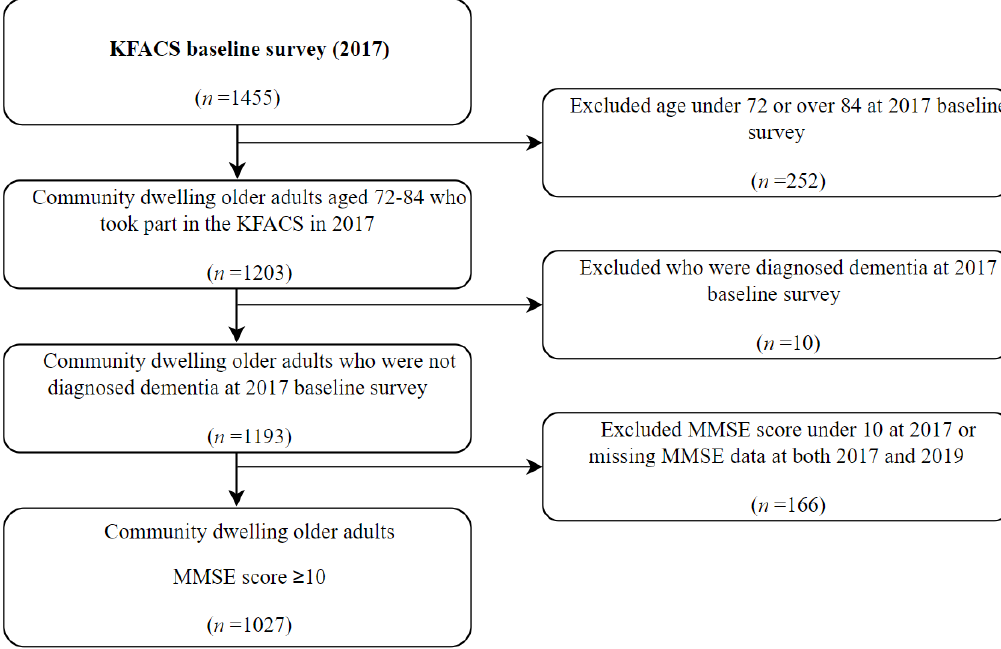
Figure 2. Flowchart of the study population of KFACS 2017 group.